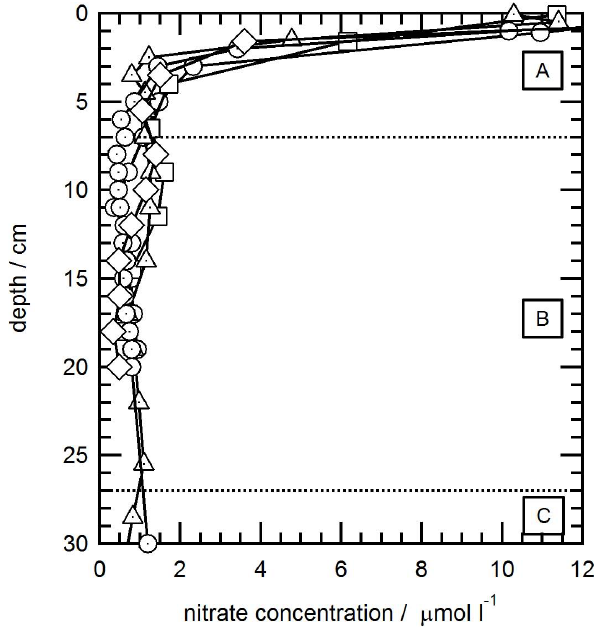
Fig. 2. Measured snowpack nitrate concentrations at Dome C from two sites during December 2009 to January 2010. Dashed lines are the depths where the stratigraphy changes within a typical snow- pack profile demonstrating the uniformity of nitrate profile within the snow cover at Dome C. The dotted circles represent the nitrate profile used in the calculation of NO 2 flux measurements as it was measured at the site of the majority of snowpack e -folding depth and reflectivity